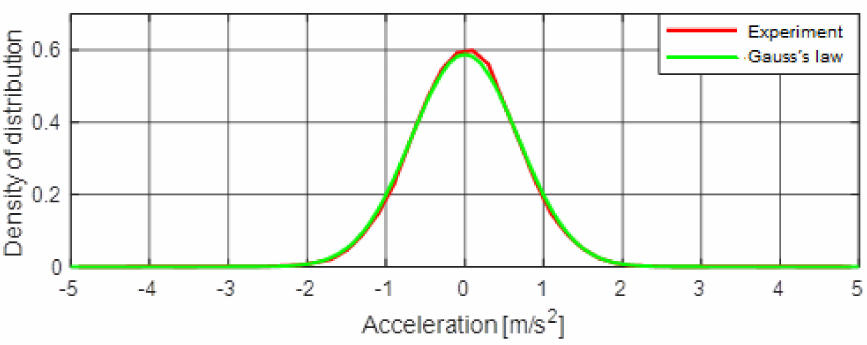
Figure 40. Density of probability distribution, acceleration on vehicle FA, V = 15.18